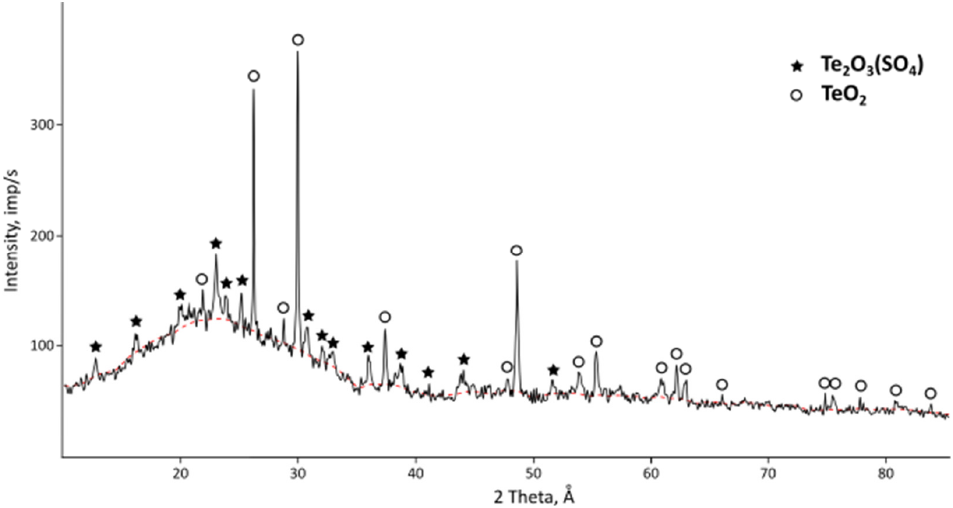
Figure 10. X-ray pattern of obtained condensate. The condensate is the initial middling intended to obtain elemental tellurium by known